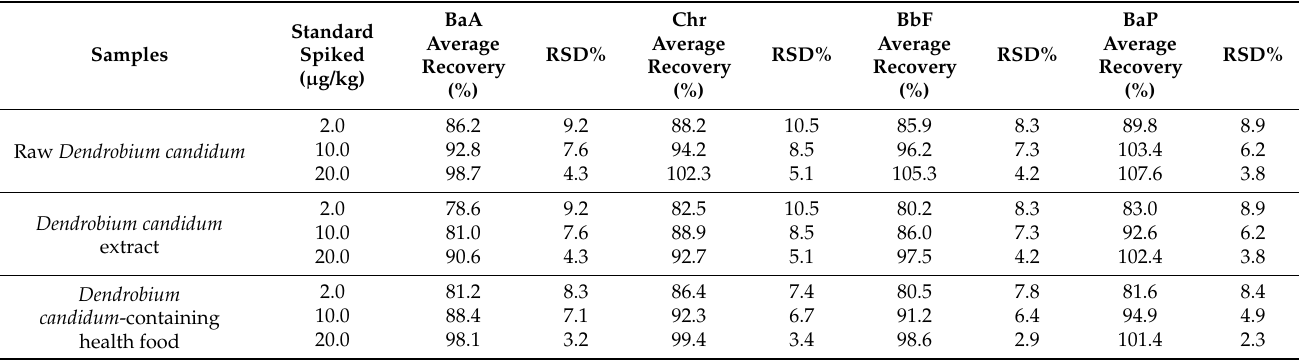
Table 2. Recovery of PAH4 from Dendrobium candidum -containing samples (n = 6).